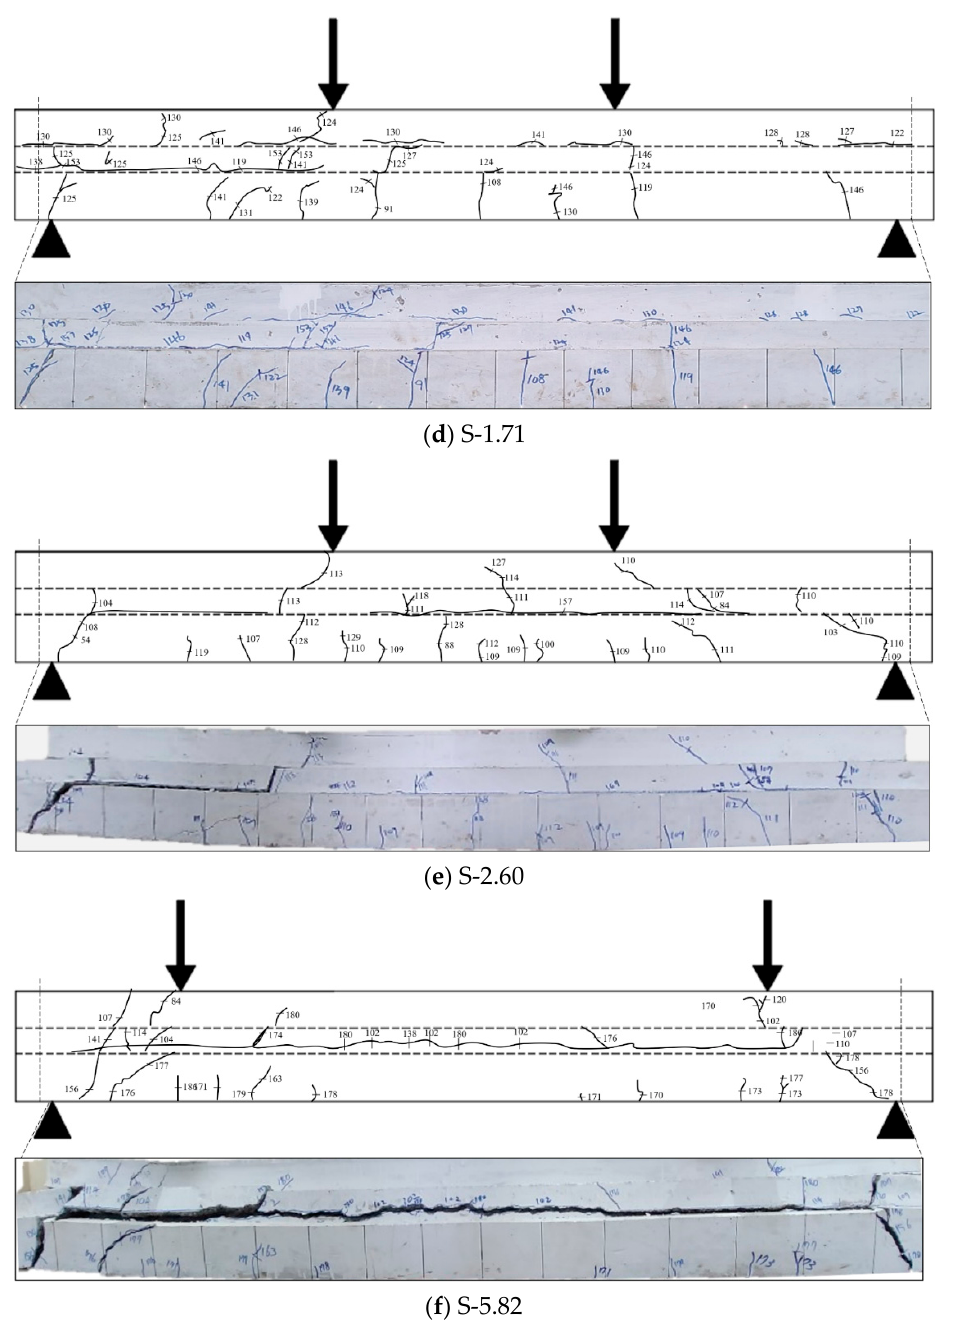
Figure 6. Failure modes of the insulation panels.